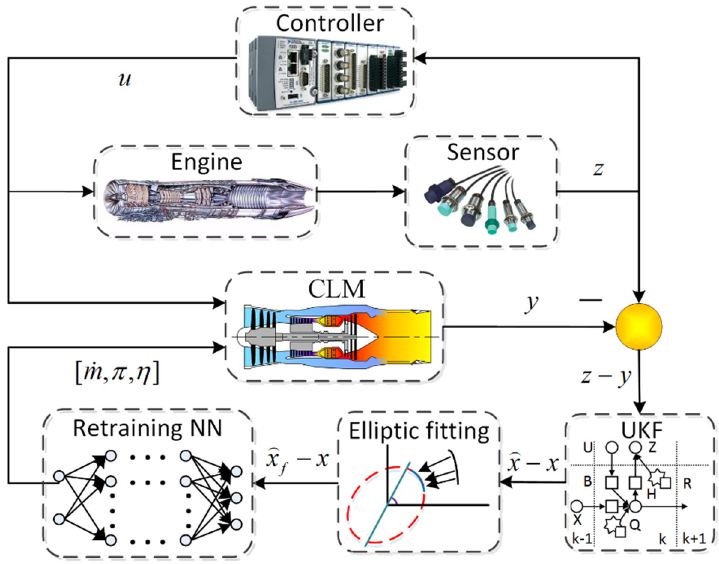
Figure 6. Illustration of the transient adaptation strategy.